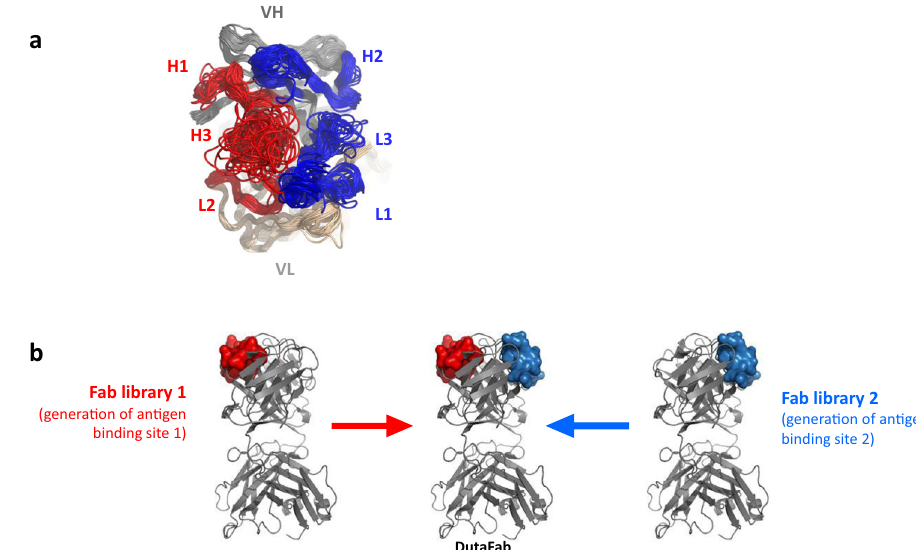
Fig. 1 The concept of DutaFab paratopes. a The DutaFab concept of separating paratopes on a single Fab. The structure shows a top-down view of 133 overlaid Fab homology models of late-stage clinical antibodies from Jain et al. 11 It is visible that CDRs 1 and 3 from one chain plus CDR 2 from the other chain each form a separate, contiguous surface. The H-side paratope shown in red comprises HCDR1, HCDR3, and LCDR2, while the L-side paratope shown in blue comprises LCDR1, LCDR3 and HCDR2. The structurally diverse HCDR3 is restricted in length and conformation in DutaFab library designs to ensure modularity. b Discovery principle of DutaFabs. Individual paratopes are isolated by separate panning of monospeci fi c Fab phage display libraries, wherein either the H-side or the L-side is diversi fi ed in a subset of residues of the relevant CDRs. DutaFabs are generated by gene synthesis and expression of Fab fragments that comprise all the target-speci fi c paratope residues against both